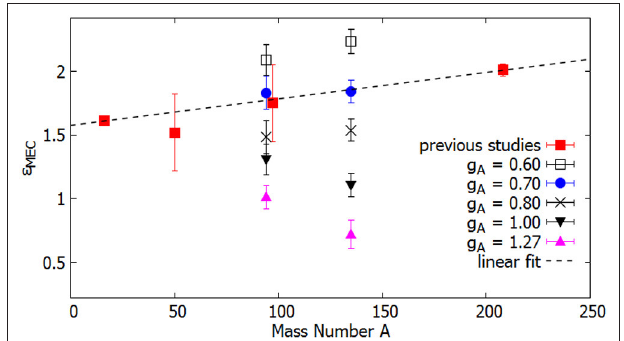
FIGURE 9 | Mesonic enhancement factors ǫ MEC of the previous studies and the study of Kostensalo and Suhonen [71] as a function of the mass number A . The red squares represent the previous systematic studies done in the A 16 and A 208 regions and the separate studies done for 50 K and 96 Y. ≈ ≈ The other points represent the results of Kostensalo and Suhonen [71] for different effective values of g A . The linear fit is an error-weighted fit, where the results of the previous studies and the study [71] with g A = 0.70 are